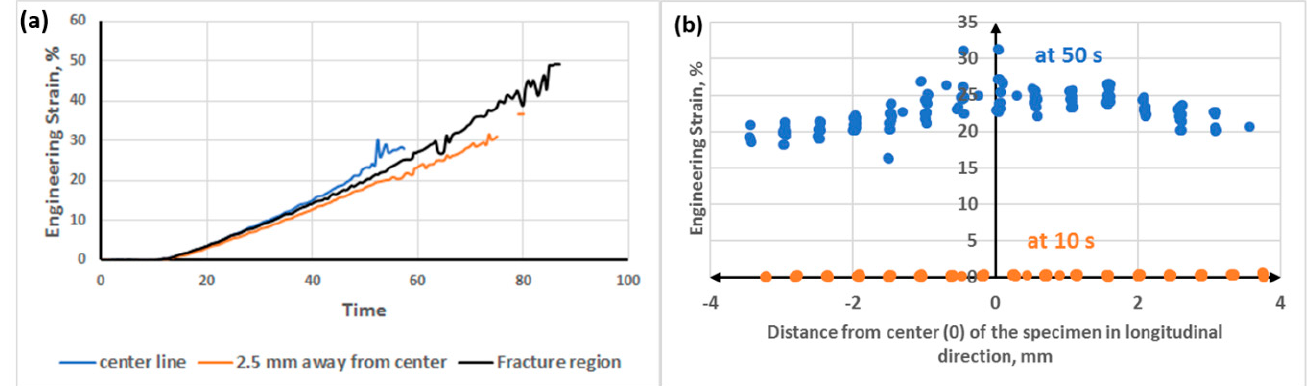
Figure 9. Strain evolutions calculated using the pictures captured during the tensile test at 535 and analyzed using the GOM Correlate software: ( a ) strain evolution at the center and 2.5 mm away from the center in the longitudinal direction of the specimen as a function of test time, and ( b ) strain distribution within 5 mm distance of the center in the longitudinal direction of the specimen at two different times.